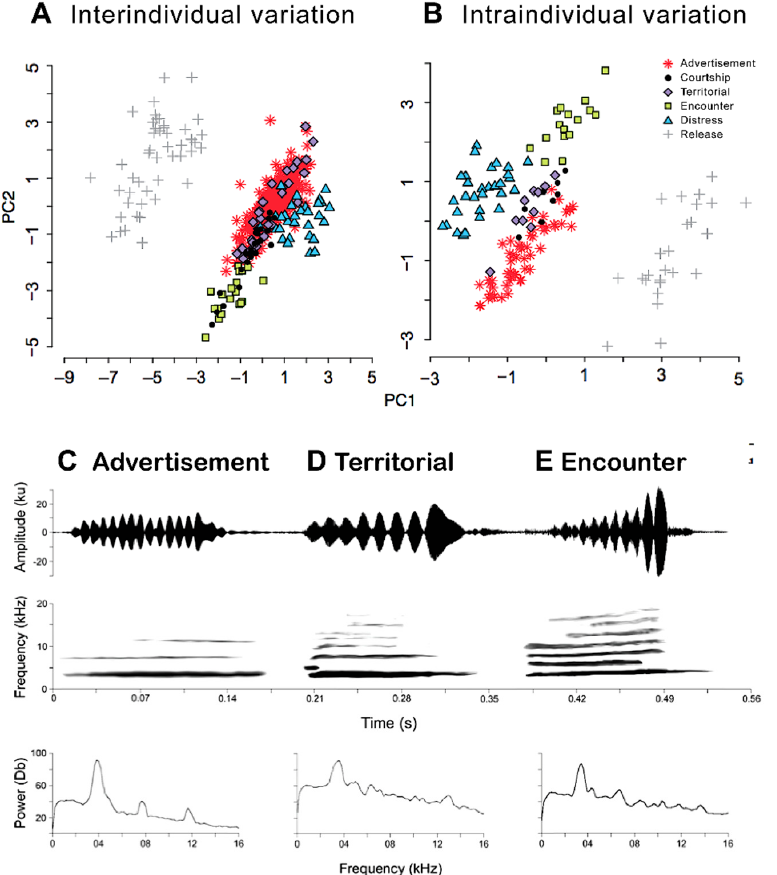
Figure 152. Call types in Nymphargus grandisonae . ( A ) Principal component analyses (PCA) of call variables for different types of calls of all individuals. ( B ) PCA plot showing call variation within an individual. ( C , D , E ) Oscillogram, spectrogram, and power spectrum of different types of calls. Modified from Hutter et al. [51].